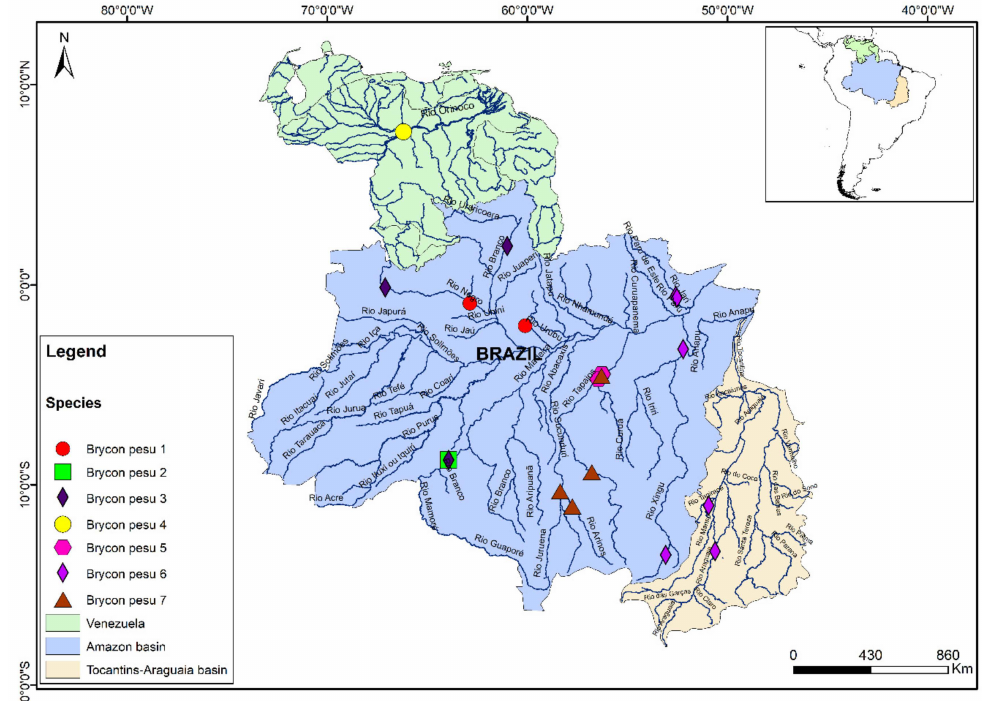
Figure 3. Distribution of the MOTUs of Brycon pesu identified in the molecular